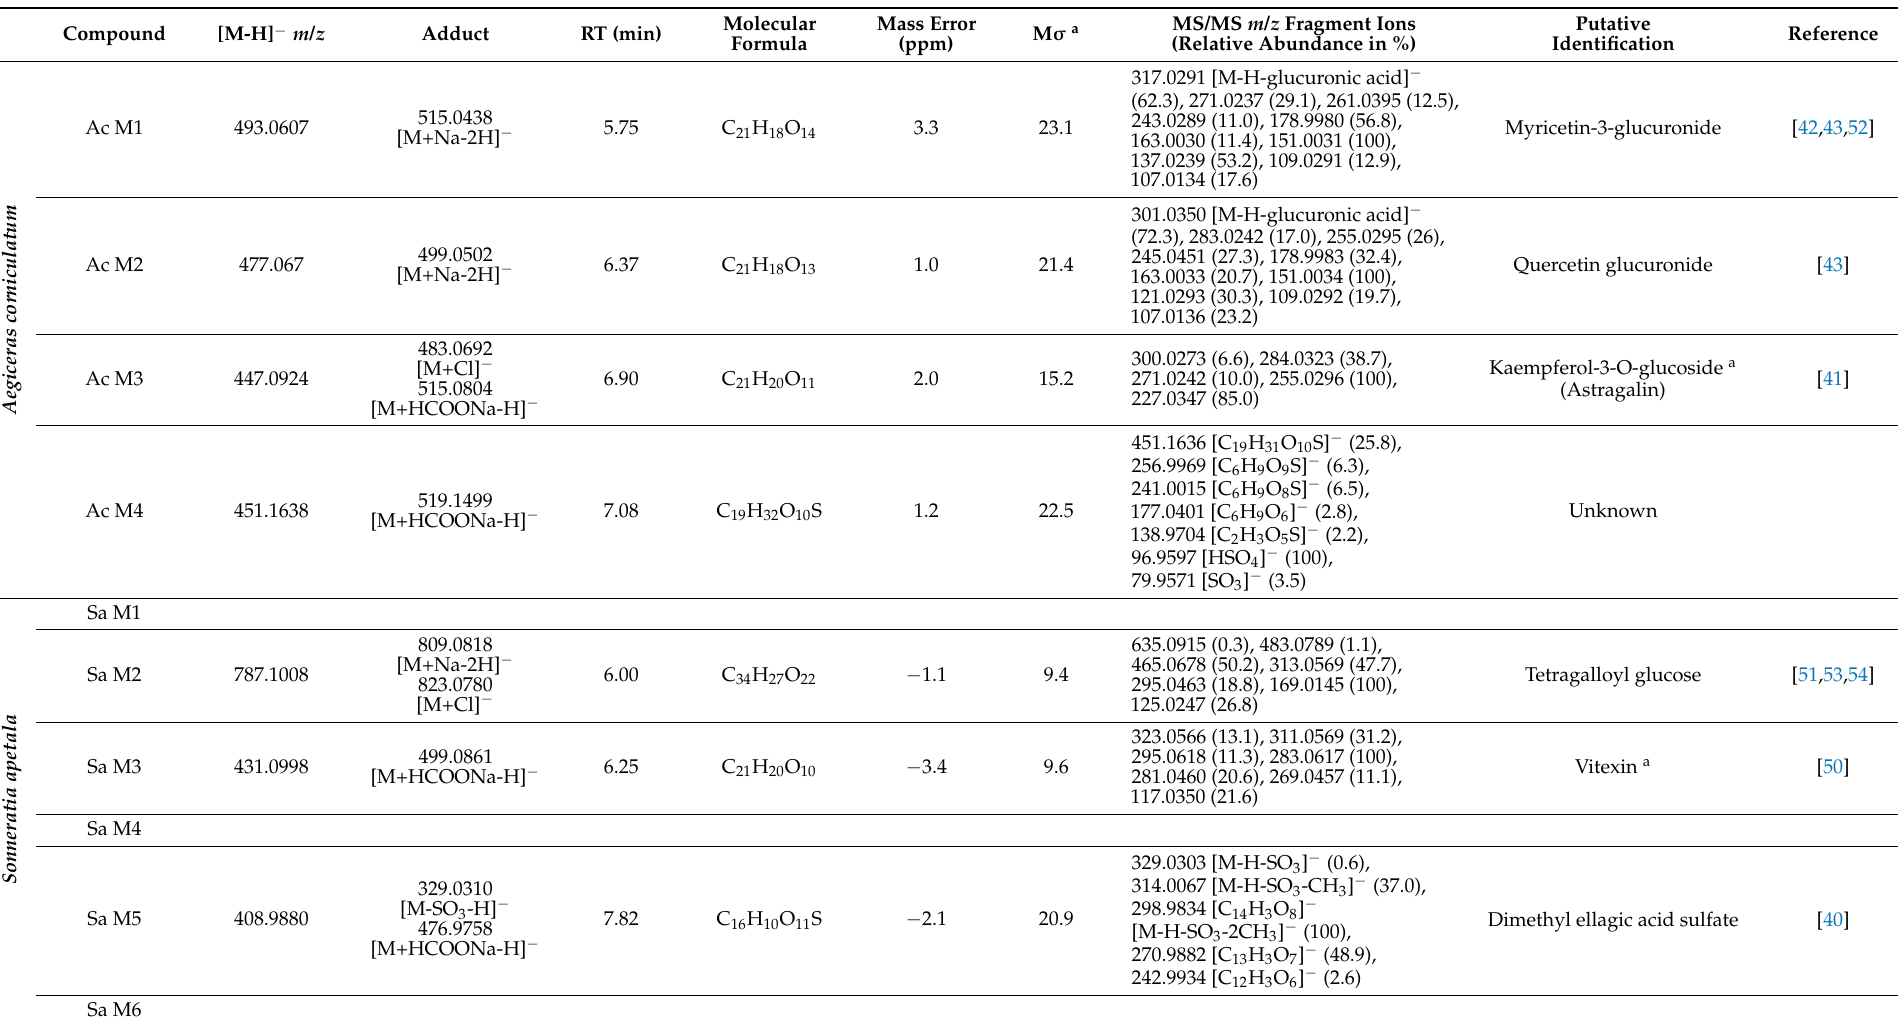
Table 3. List of Aegiceras corniculatum and Sonneratia apetala leaf methanolic extracts’ base peak chromatogram (BPC) major compounds detected via